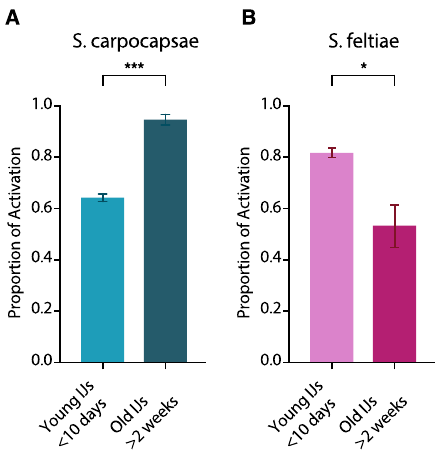
Figure 2. The effect of IJ age on activation. ( A ) S. carpocapsae IJs; ( B ) S. feltiae IJs. Populations of